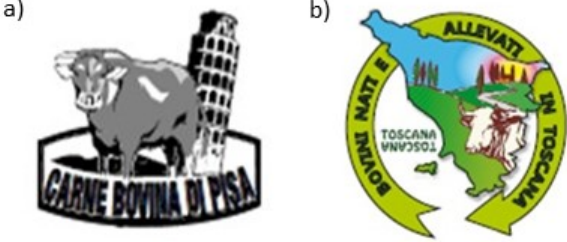
Figure 2. ( a ) The label Carne Bovina di Pisa; ( b ) the label Toscana Toscana. Source: website of Toscana Toscana label.